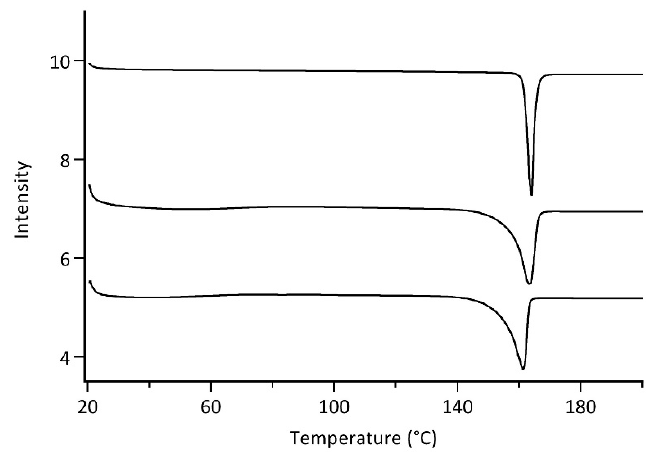
Figure 5. Differential scanning calorimetry (DSC) thermograms of ( A )CLX crude powder, ( B )physical mixture (PM) and ( C )optimized CLX-NC.